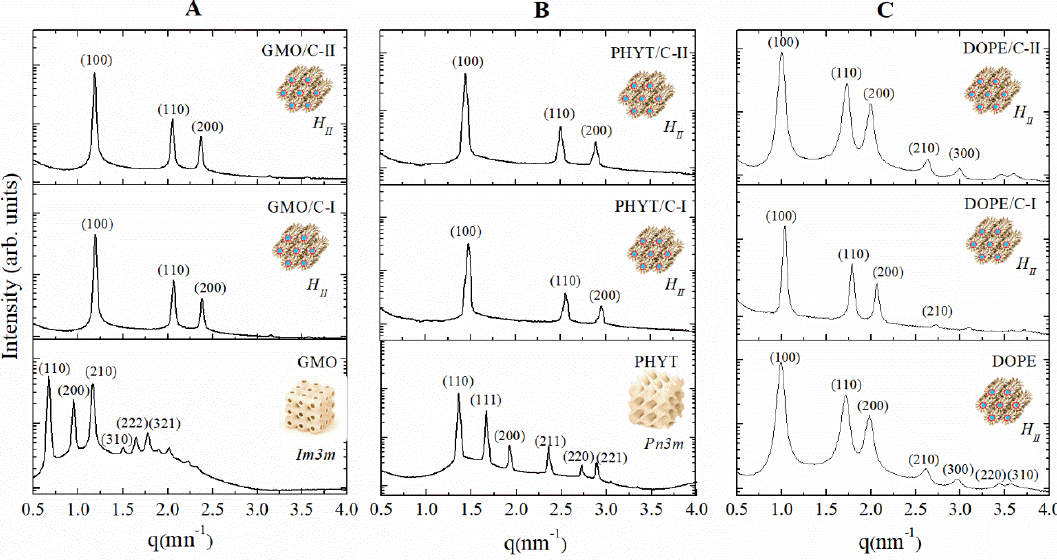
Figure2. Small-angleX-rayscattering(SAXS)synchrotronprofilesfor( A )GMO,( B )PHYTand( C )DOPE Figure 2. Small-angle X-ray scattering (SAXS) synchrotron profiles for ( A ) GMO, ( B ) PHYT and ( C ) empty and loaded with C-I and C-II compounds. DOPE empty and loaded with C-I and C-II compounds. Table 1. Phase structure, lattice parameters and diameter of aqueous channels of GMO, PHYT and DOPE empty and loaded.